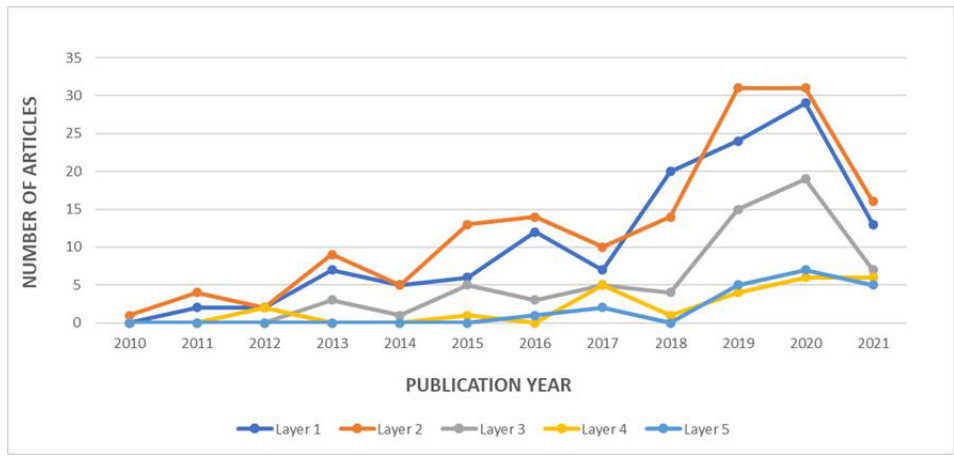
Figure 9. Number of articles in each layer from 2010 to 2021.